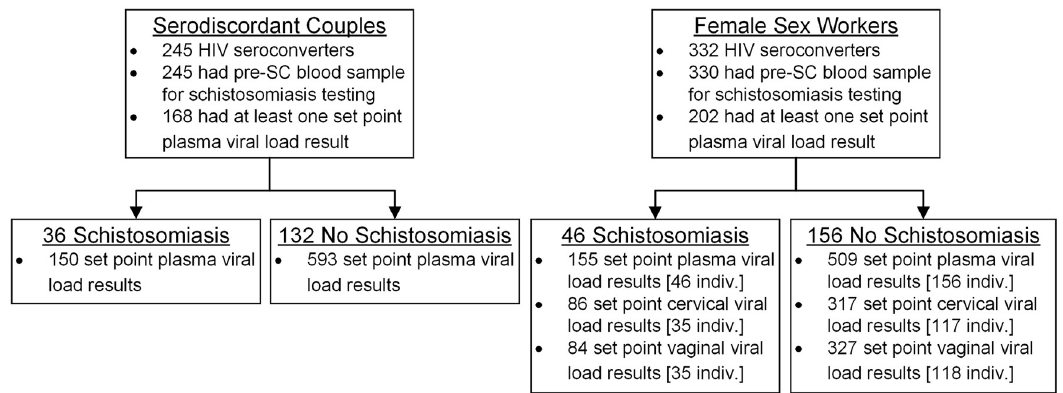
Fig 1. Eligibility and availability of samples from HIV-1 seroconverters in the serodiscordant couples and female sex worker